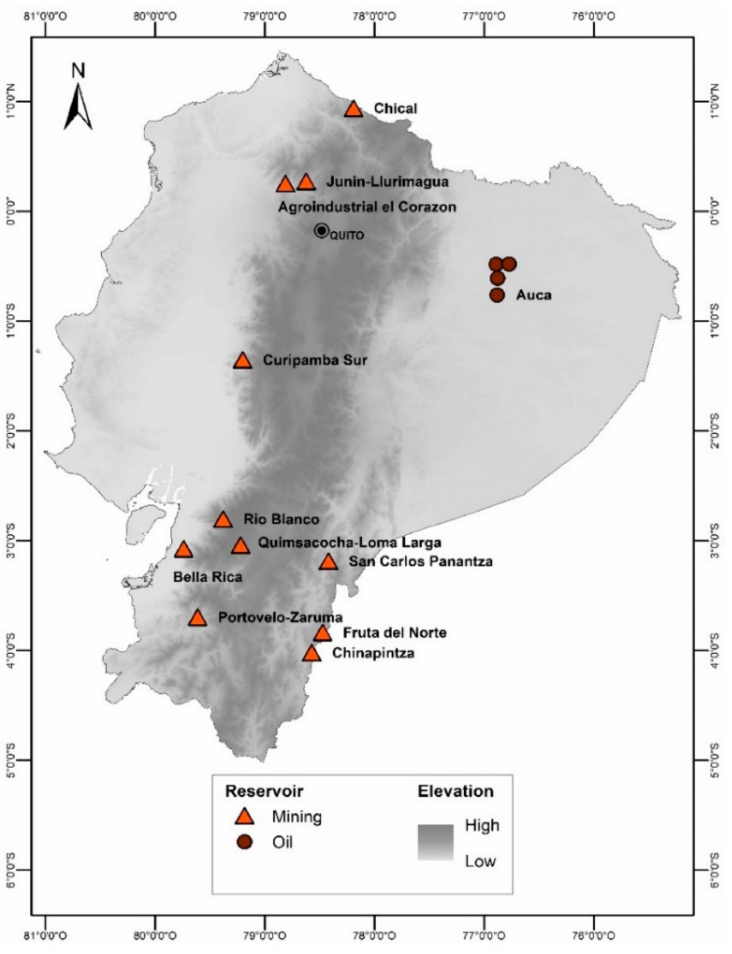
Figure 1. Map of study area. Location of the studied metallic reservoirs and studied oil